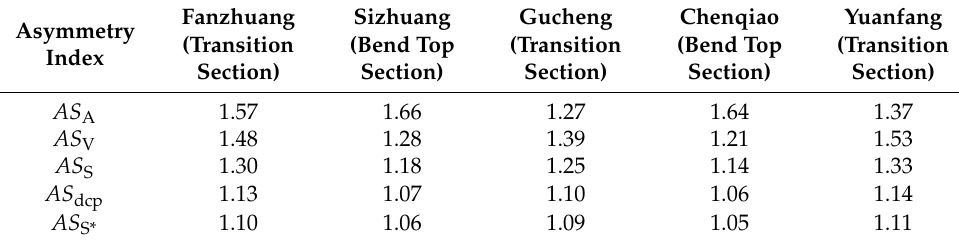
Table 5. Asymmetry index of wandering river bend top and transition section (silting state, S = 90 kg/m 3 ).